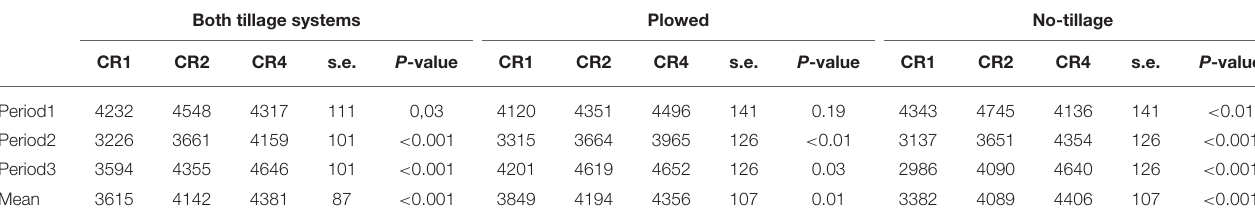
TABLE 2 | The average spring wheat yield (kg/ha) in different tillage systems, time periods, and crop